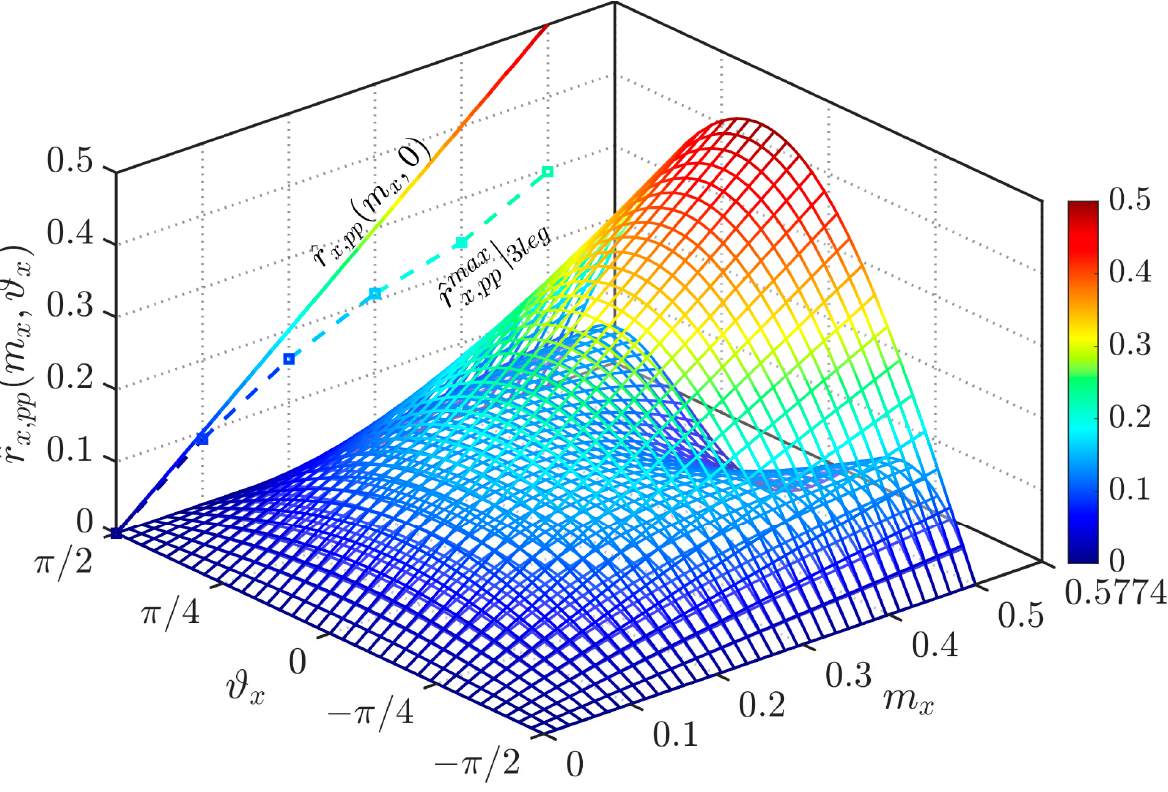
11 of 26 Table 1. Experimental setup circuital parameters. Parameter